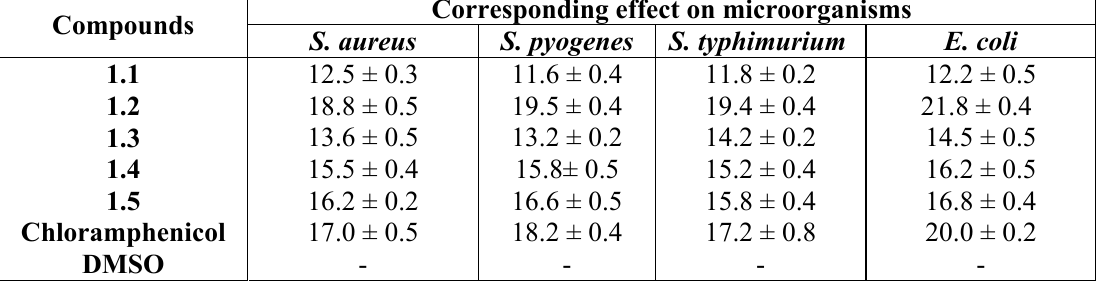
Table 1. Antibacterial activity of the chalcone and its cyclized products, positive control chloramphenicol and negative control (DMSO) measured by the Halo Zone Test (unit, mm).